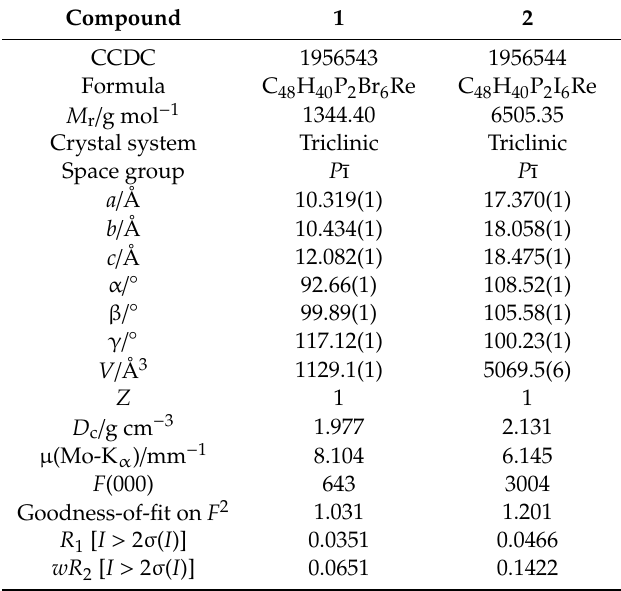
Table 1. Summary of the crystal data and structure refinement parameters for 1 and 2 .